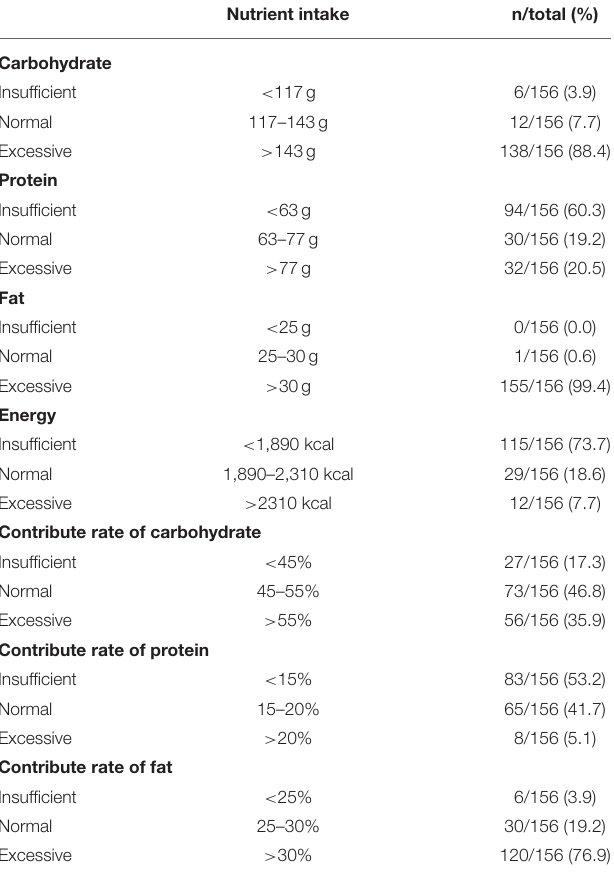
TABLE 2 | Summary of nutrient intake data of GDM patients recorded at the first visit to the nutrition department ( n = 156). Nutrient